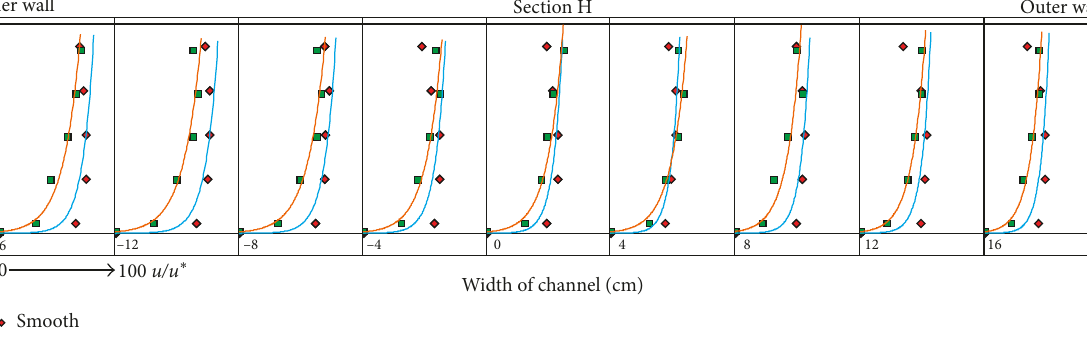
Figure 11: Comparison of velocity variation in section H.